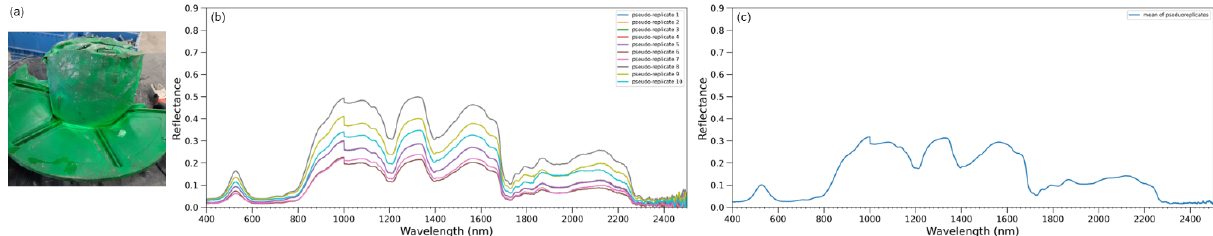
Figure 3. Spectra of field sample and figure of the object from which the spectra were obtained (a) . Spectrum (b) shows the pseudo-replicates of the low homogeneous field samples. Spectrum (c) is the mean of all the pseudo-replicates. No splice correction was applied. The picture was taken by Giulia